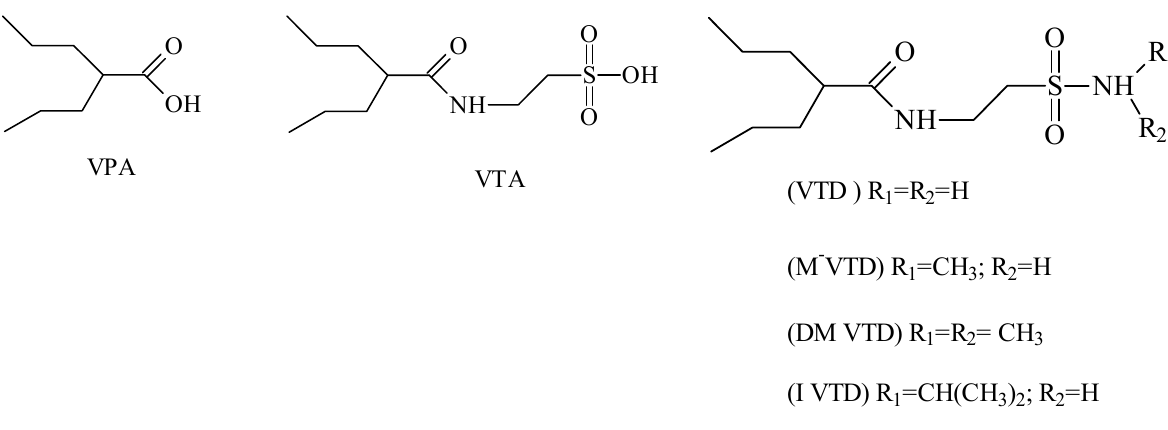
Figure 2. Valproyltaurine derivatives.